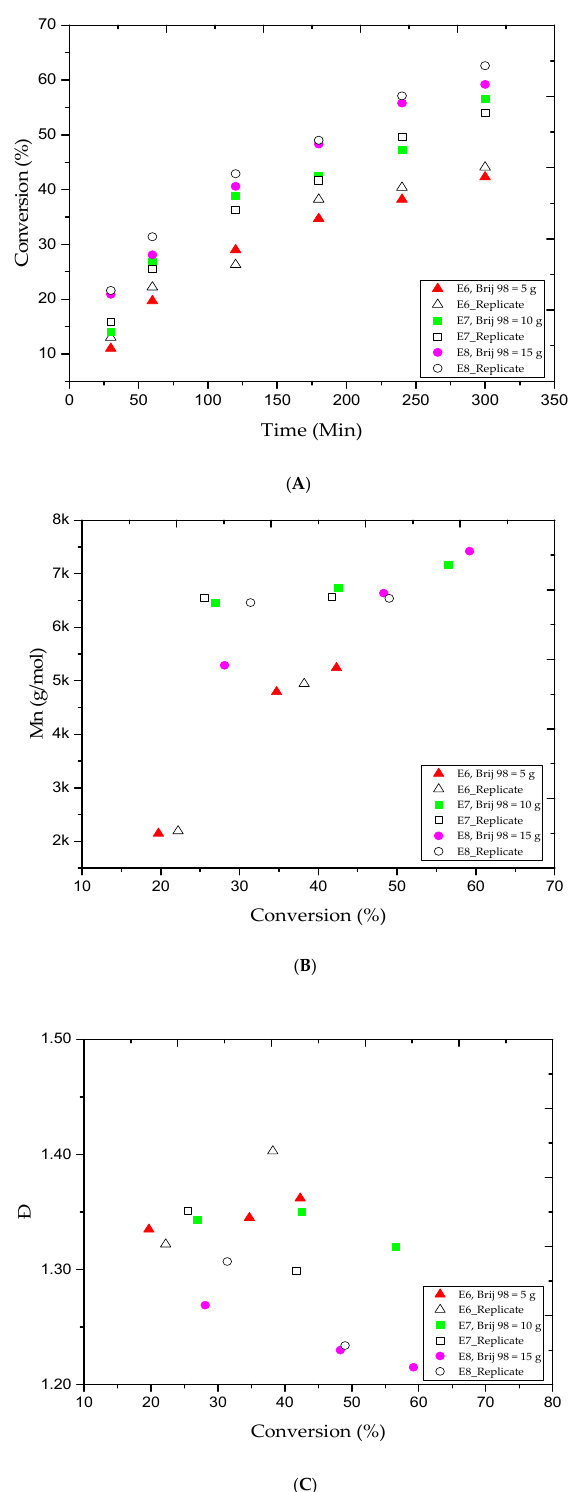
Figure 2. For experiments E6–E8: ( A ) methyl methacrylate (MMA) conversion versus reaction time, ( B ) variations in the experimental number-average molar mass (M n ) versus methyl methacrylate (MMA) conversions, and ( C ) variations in the polydispersity index (Ð) versus methyl methacrylate (MMA) conversions. A few studies [46,47] have looked at the effect of the amount of water on emulsion polymerization. This investigation was mainly focused on the monomer/water weight ratio (M/W). The M/W values for the E4, E9, E10, and E11 trials were 0.160, 0.140, 0.125, and 0.112 g/g, respectively.